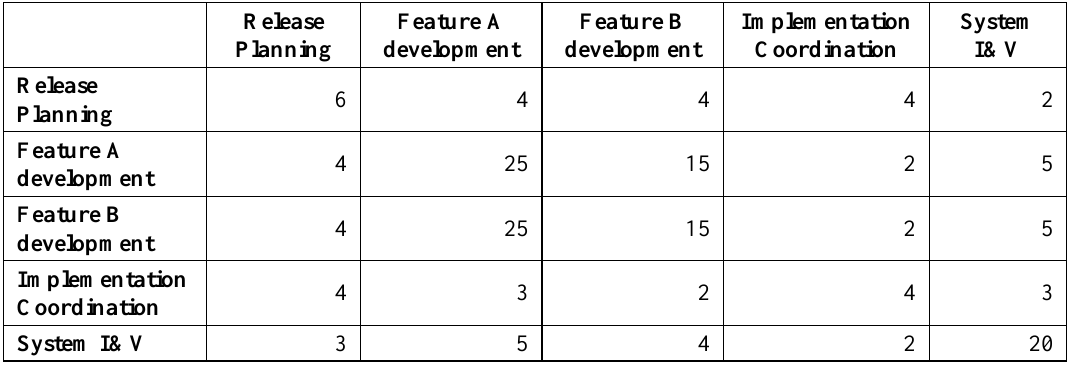
Table 5. An example of the basic inter-professional matrix